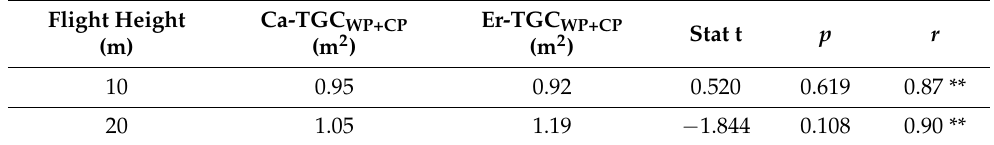
Table 2. Total green cover in weeded and control plots (WP and CP) was obtained using Canopeo (Ca- TGC WP+CP ) and Erdas (Er-TGC WP+CP ). Student t -test, p -value and Pearson correlation coefficient ( r ). Flight Height Ca-TGC WP+CP Er-TGC WP+CP Stat t p r (m) (m 2 ) (m 2 ) 10 0.95 0.92 20 1.05 1.19 − 1.844 0.108 0.90 **